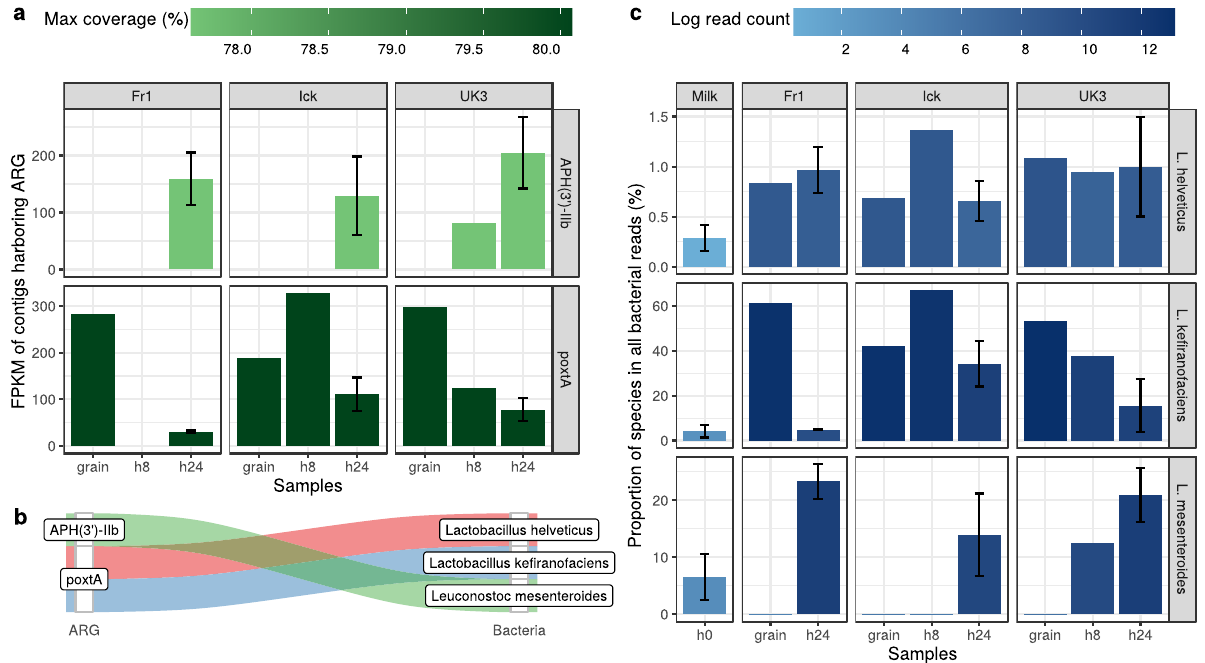
Figure 5. Changes during kefir fermentation. ( a ) Antimicrobial resistance gene (ARG) abundance expressed as fragments per kilobase per million fragments (FPKM) based on the alignment of bacterial reads to the ARG harbouring contigs. ( b ) ARGs and their most likely origins. ( c ) Relative abundances of bacteria with a probable ARG